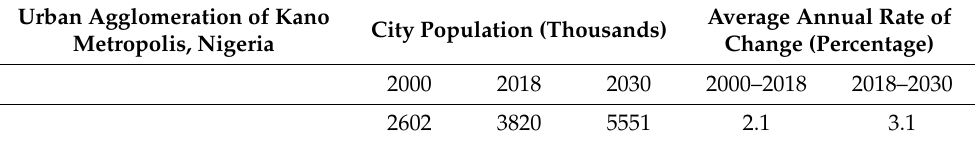
Table 1. Urban population growth of Kano metropolis. Urban Agglomeration of Kano Metropolis, Nigeria